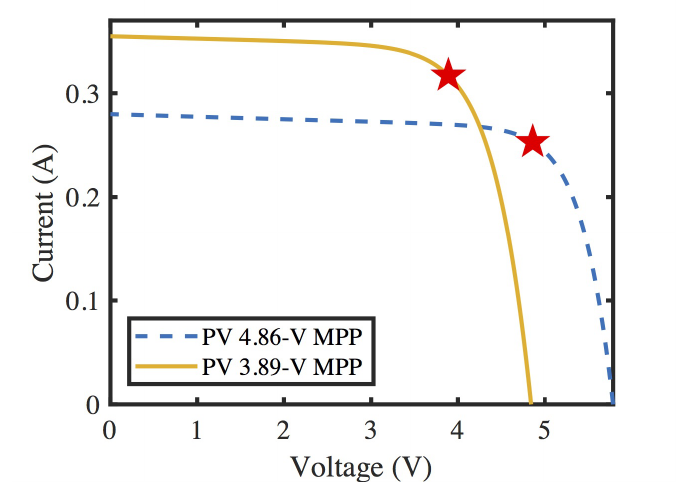
Figure 7. Current–voltage (I–V) curves for two PV modules with different maximum power point (MPP)